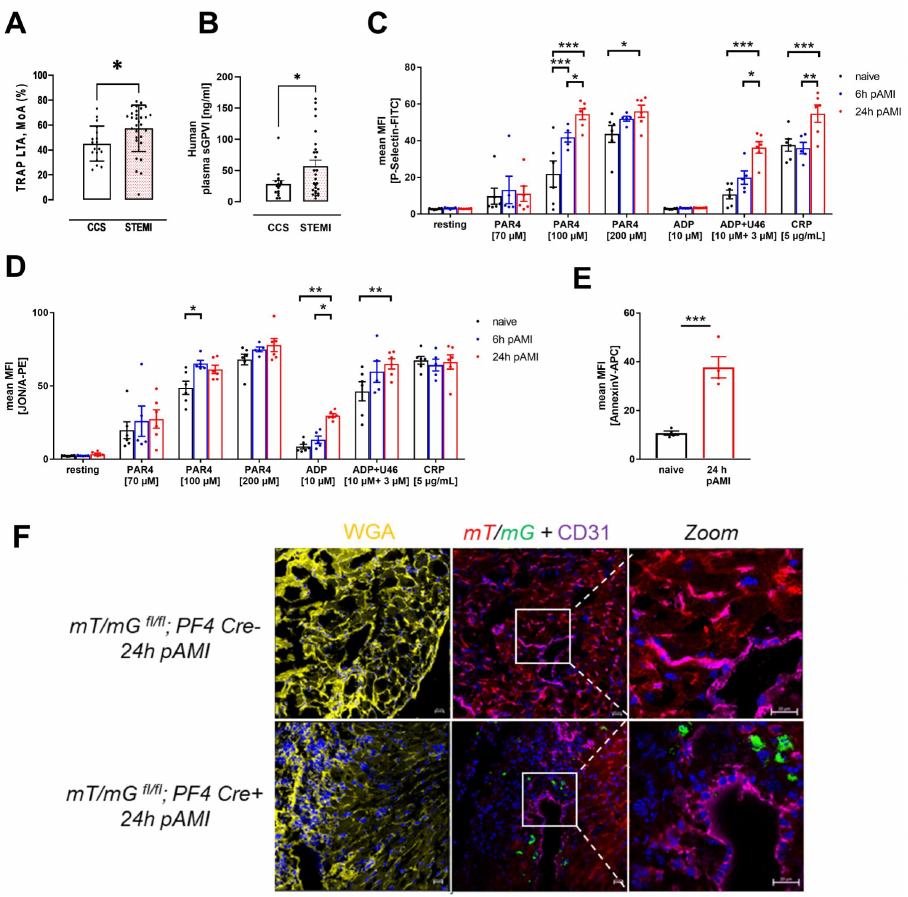
Figure 1. Enhanced platelet activation in STEMI patients and in a mouse model of myocardial is- chemia and reperfusion. ( A ) Light transmission aggregometry was performed with TRAP stimulated platelets isolated from CCS and STEMI patients. MoA: maximum of aggregation. ( B ) Plasma analyses of soluble GPVI (sGPVI). (CCS: n = 17; STEMI: n = 16–27). ( C ) Externalization of P-selectin at the platelet surface and ( D ) activation of α IIb β 3 integrin of naïve mice and 6 and 24 h post AMI at resting state or activated with indicated agonists; n = 6. ( E ) Annexin V binding of platelets from naive mice and 24 h post AMI; n = 4. ( F ) Wheat germ agglutinin (WGA) staining in yellow to identify the infarct zone by plasma membrane integrity and PECAM staining (violet) to visualize blood vessels in heart sections from mT/mG;PF4-Cre- (upper panel) and mT/mG;PF4-Cre+ mice (lower panel) 24 h post AMI. Scale bar 20 µ m. Data are presented as means ± SEM. Statistical analyses were done by two-tailed unpaired Student’s t -test ( A , B , E ) or by Two-Way ANOVA followed by Sidak post hoc ( C , D ). * p < 0.05, ** p < 0.01, *** p <